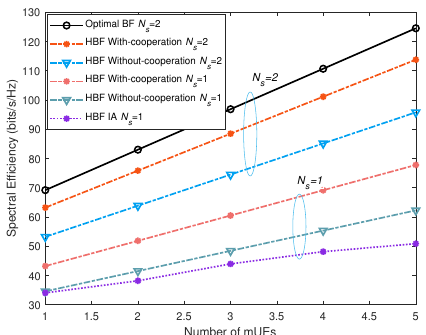
Figure 5. Effective system sum rate versus the number of